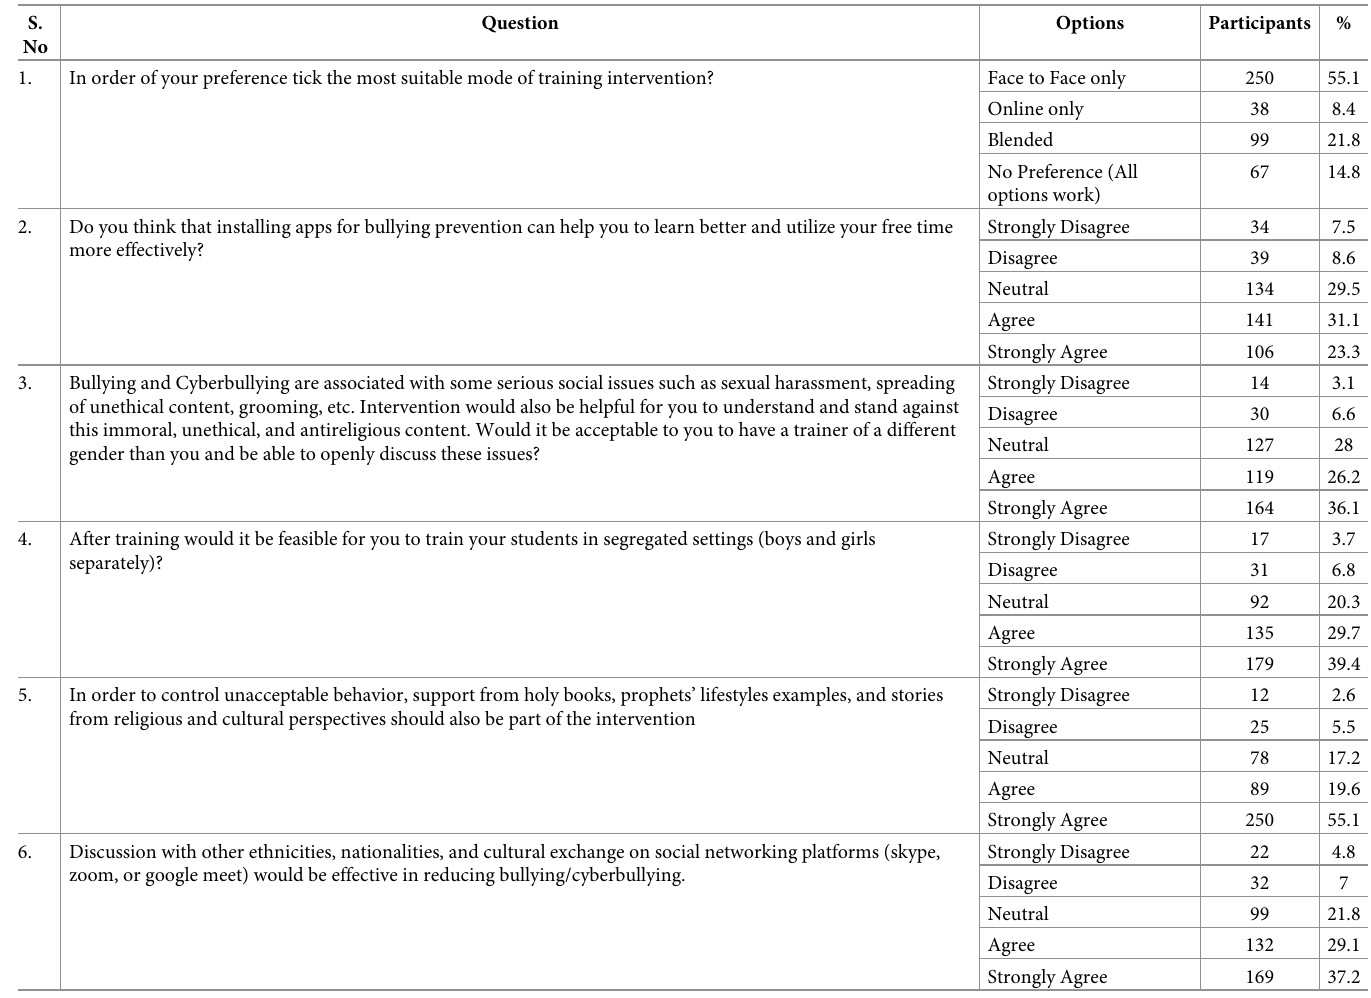
Table 9. Teachers’ opinions about new intervention